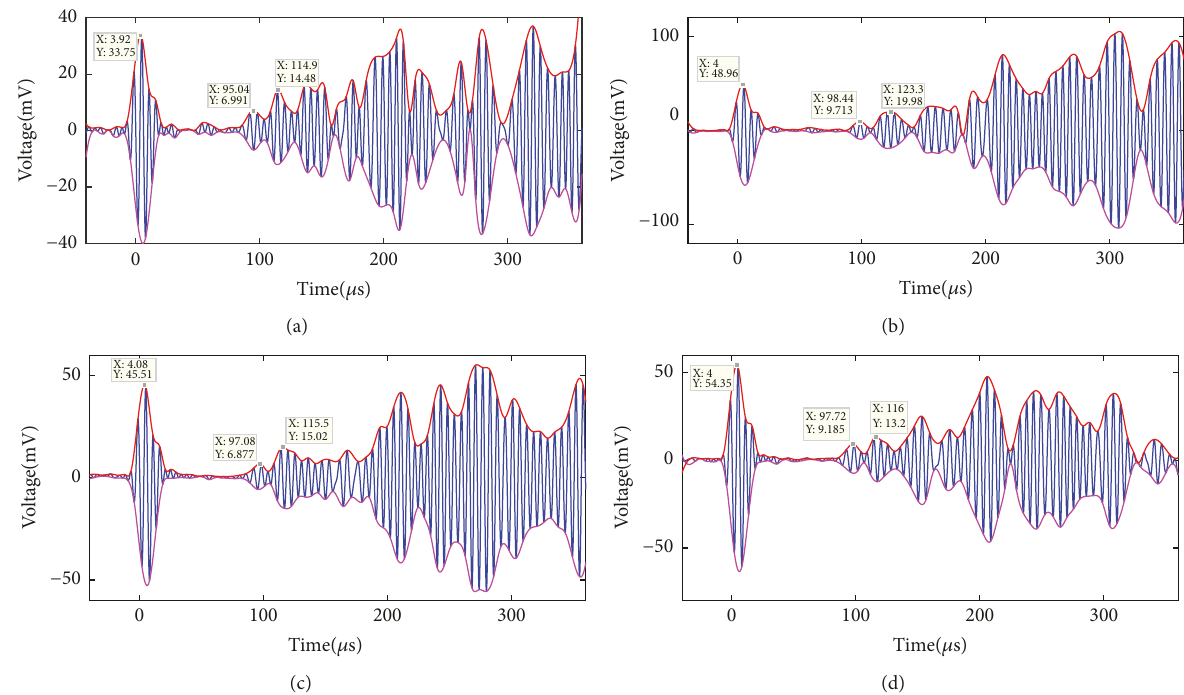
Figure 8: Collected signals of piezoelectric transducers after filtering (a) no. 1, (b) no. 2, (c) no. 3, and (d) no. 4 when the rotor rotates at 15Hz.